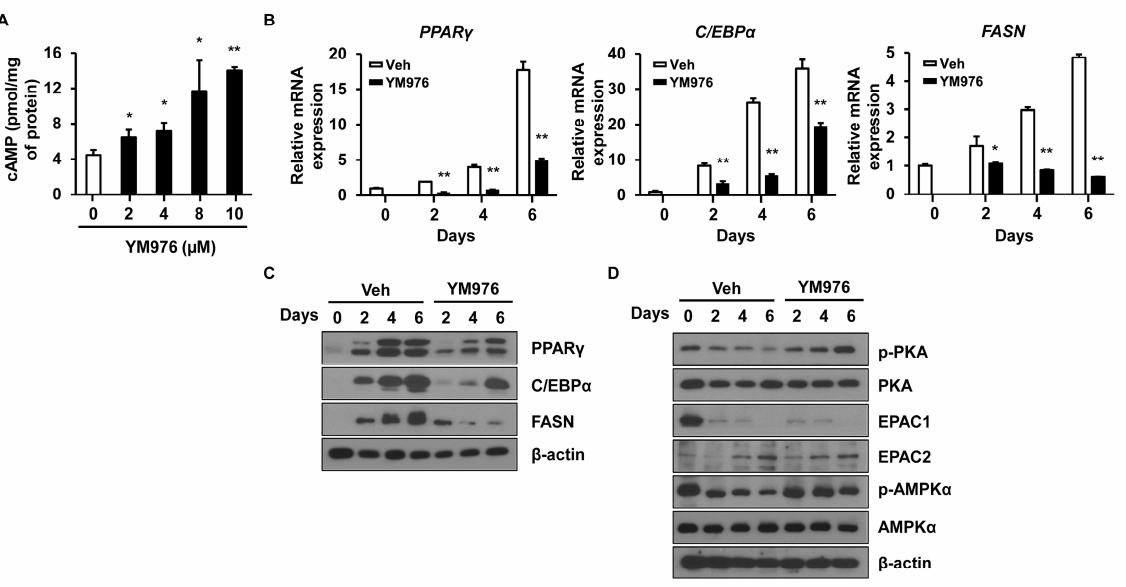
Figure 3. YM976 increases the level of cAMP and decreases the expression of adipogenic genes. Cells were treated with Veh or YM976 at the indicated days. ( A ) Intracellular cAMP level was analyzed by ELISA. ( B ) The mRNA expression levels of PPARγ, C/EBPα, and FASN after treatment with YM976 were determined by qRT-PCR. ( C ) Protein levels of PPARγ, C/EBPα, and FASN were analyzed by Western blot. ( D ) Expression levels of indicated protein were assessed by immunoblotting. In ( A , B ), n = 3 per group. In C and D, blots are representative of three independent experiments. Values indicate mean ± SD. * p < 0.05; ** p < 0.01. Data were assessed by one-way ANOVA with Dunnett’s post hoc test.